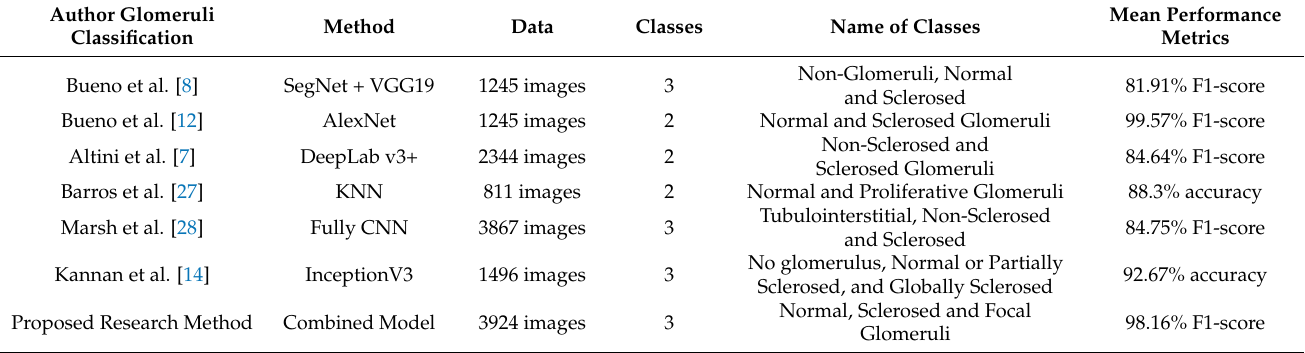
Table 9. Previous works and the performance metrics regarding glomeruli